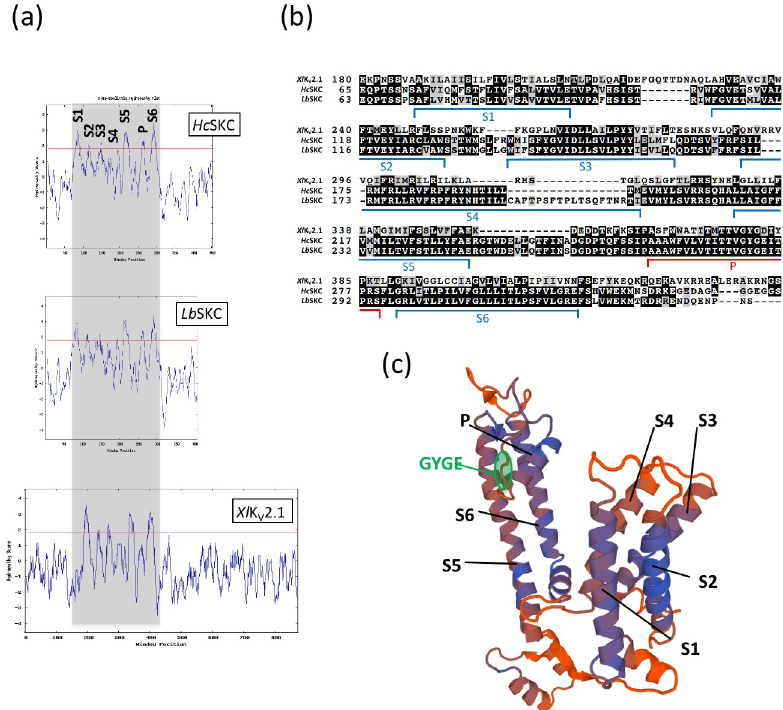
Fig 1. In silico prediction of a Shaker -like channel in the fungus Hebeloma cylindrosporum . The hydrophobicity profiles of the Shaker subunits from H . cylindrosporum ( Hc SKC), L . bicolor ( Lb SKC), and X . laevis ( Xl K V 2.1) (a) and their partial amino acid sequence alignment (b) predicted six transmembrane domains (S1 to S6). One pore domain in Hc SKC and Lb SKC subunits containing the conserved G[YF]G[DE] motif of the Shaker channel selectivity filter was also detected. The S4 transmembrane domain corresponds to the predicted voltage-sensor domain. (c) The plausible 3-D model of the fungal Hc SKC subunit showing the transmembrane (S1 to S6) and pore (P) domains was generated by homology with the 3-D structure of Rn K V 2.1 K + channel from R . norvegicus (NP_037318.1; S2 Table) as a template using Swiss-Model server [33] (http://swissmodel.expasy.org/). The GYGE signature motif of the pore region was highlighted in green. The sequence alignment of Hc SKC and Rn K V 2.1 polypeptides is displayed in S1 Fig.